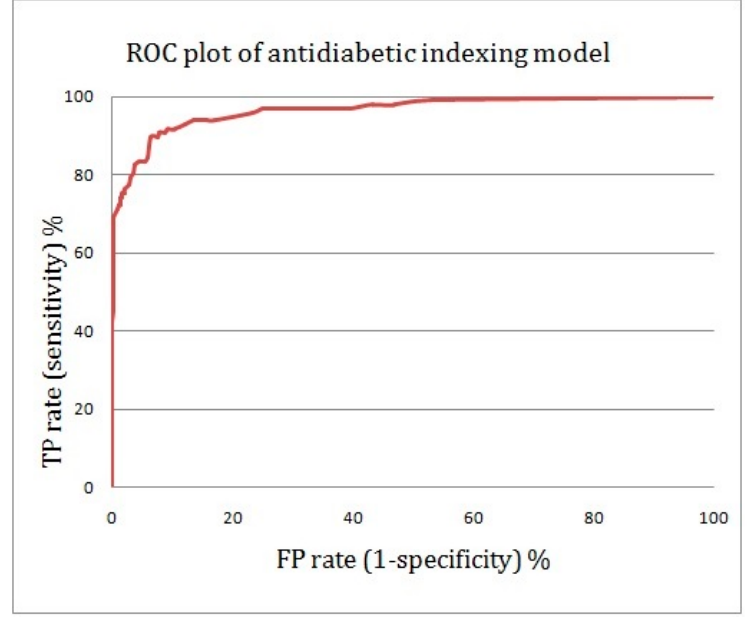
Figure 8. A receiver operating characteristic (ROC) curve showing the performance of the anti-diabetic activity-indexing model (the true positive rate is plotted against the false positive rate).